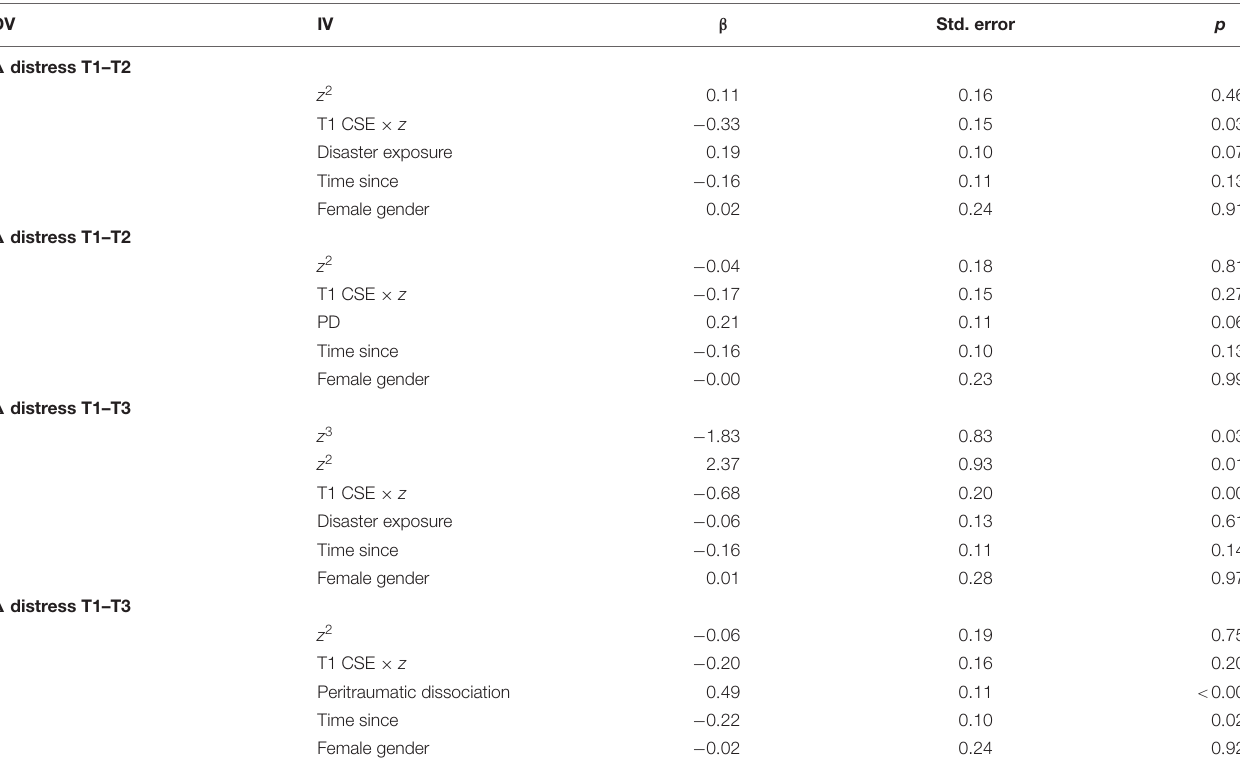
TABLE 4 | Standardized coefficients, standard error, and p -values for the cusp model in distress between time 1 and time 2 and in distress between time 1 and time 3 for Study 2. DV IV β Std. error p